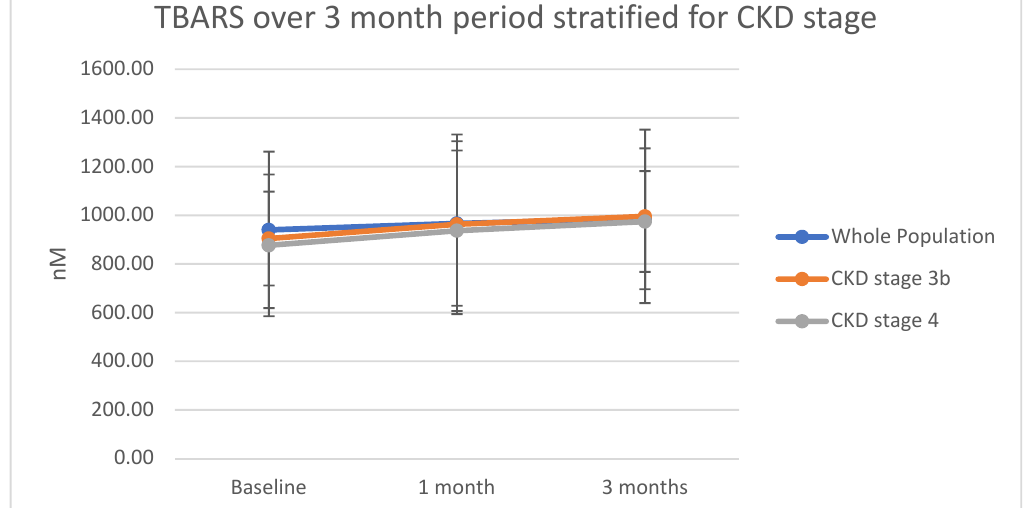
Figure 1. Thiobarbituric acid reactive substances in nM are plotted for the whole population and each individual large cohort of CKD (i.e., stages 3b and 4). Plotted points represent means, and error bars represent standard deviations.